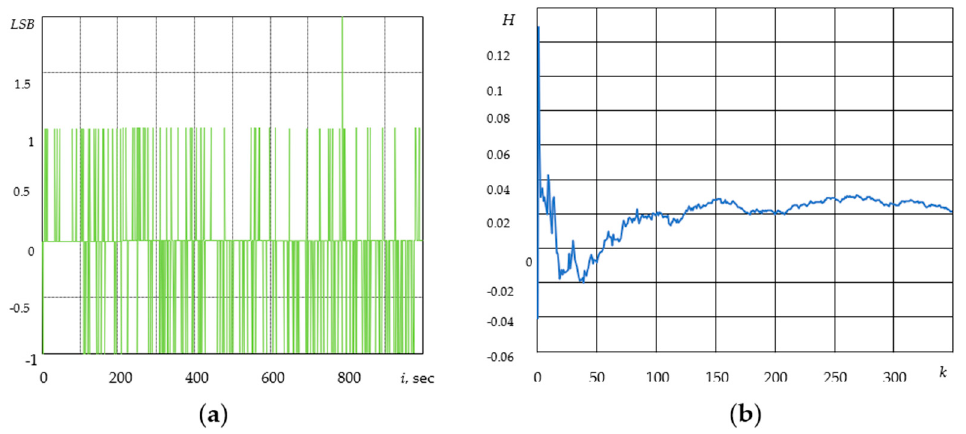
Figure 3. Accelerometer bias and drift by x coordinate ( a ), Hurst parameter ( b ).